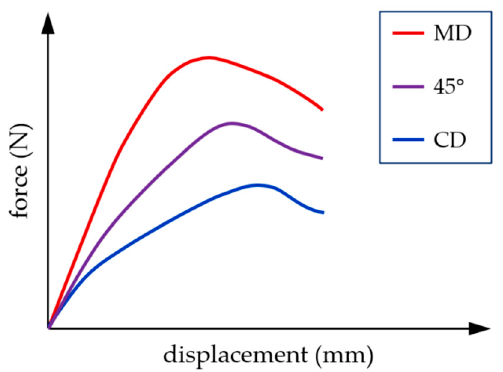
Figure 2. Mechanical behavior of cardboard in different material directions.